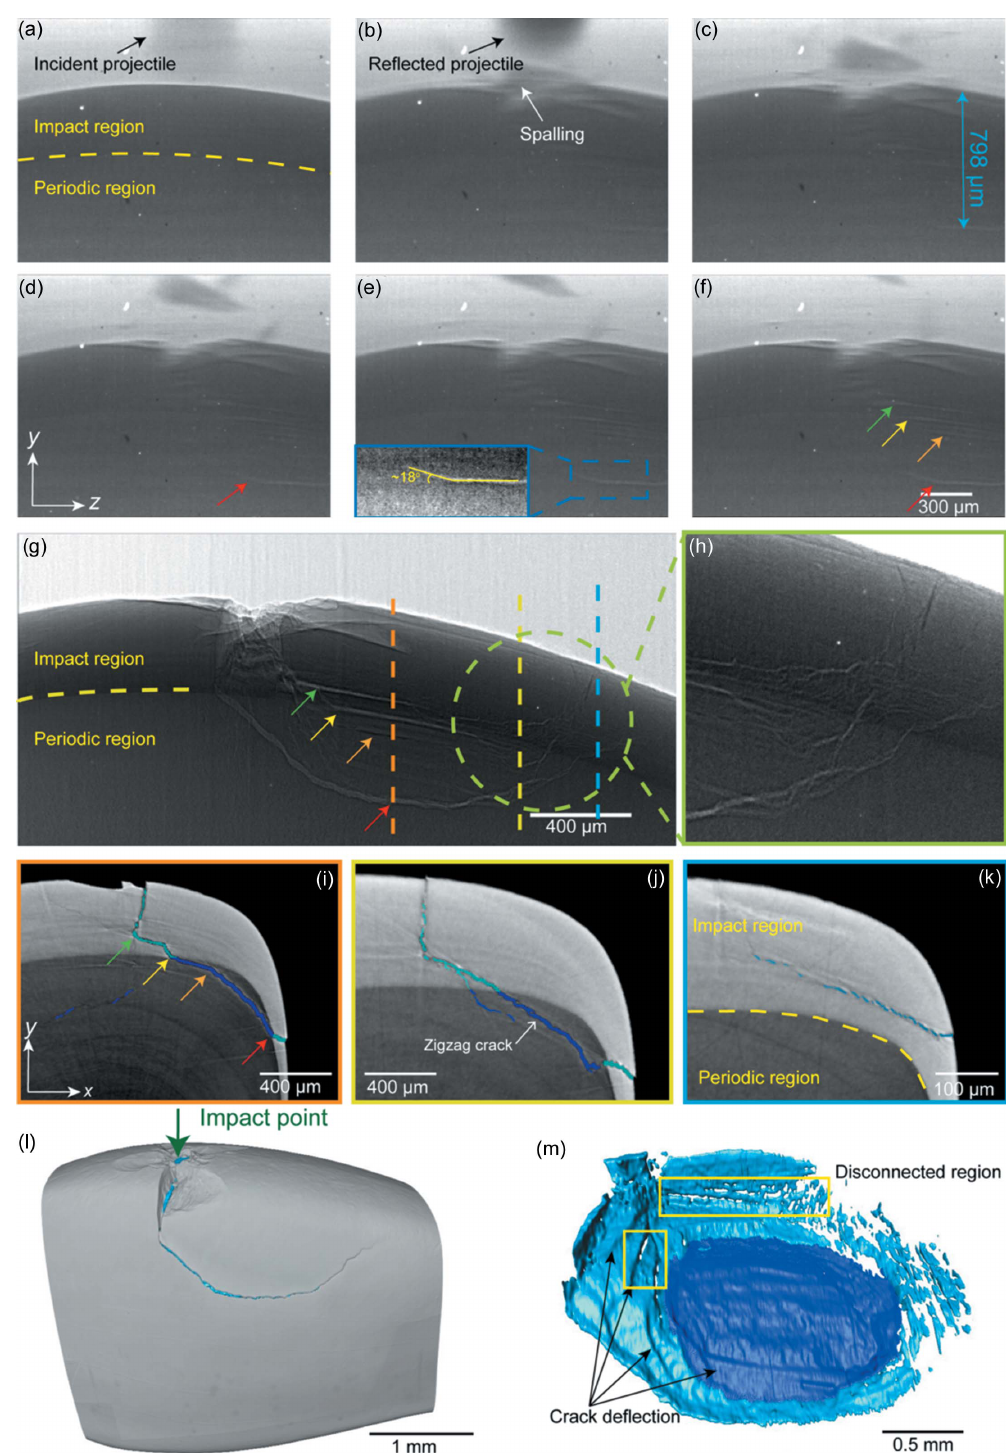
Figure 2 Dynamic structure deformation and crack evolution observed via in situ 2D fast imaging and high-resolution 3D post mortem CTexamination. ( a )–( f ) Snapshots of dactyl club under dynamic impact with time intervals of 6 m s. Catastrophic spalling and clear crack deflections can be spotted in situ . Image ( e ) shows the propagating crack starting to deflect towards (highlighted with the yellow line) the impacting point at 27 m s after the exact moment of impact, which grew further [indicated by the red arrow in ( g )] and merged with another crack system nucleated right under the impact point as shown in ( g ). Image ( g ) displays a projection of the impacted dactyl club from an ex situ CT test at a similar perspective as in the in situ 2D imaging, with some major deflection sites indicated with arrows. Image ( h ) shows crack-branching behaviors while they were deflected towards the surface of dactyl club. ( i )– ( k ) Slices of CTreconstruction of damaged dactyl club denoted in ( g ). The main crack was deflected around the interface of the impact-periodic region. Within the periodic region, the crack was deflected periodically forming a zigzag-shaped crack path. At the end of main crack, the crack branched into microcracks and propagated to the surface of dactyl club as shown in ( k ). ( l ) 3D rendering of damaged dactyl club. ( m ) 3D distribution of the main crack system developed in the dry dactyl club sample. Dark blue: cracks within the periodic region. Light blue: cracks within the impact Zheng Dong et al. (cid:3) Study of extreme damage resistance in stomatopod dactyl club 779